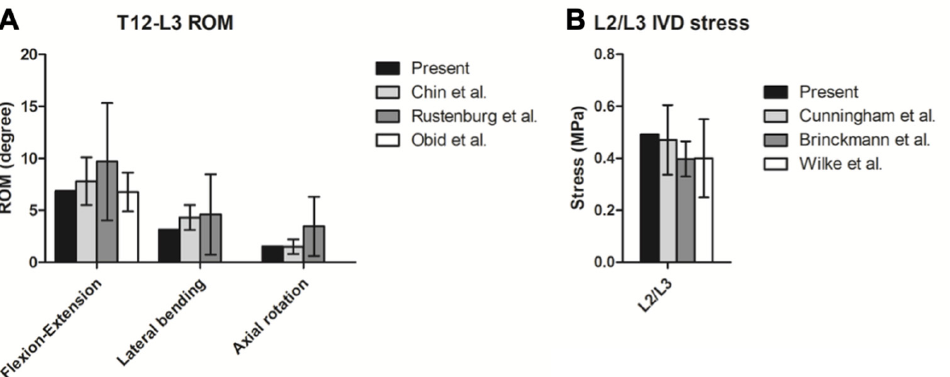
Figure 3. Validation of the present FE model. Comparisons between the ( A ) ROM and ( B ) IVD pressure of the present intact model with the literature [31–36] (presented in mean and standard devia- tion).